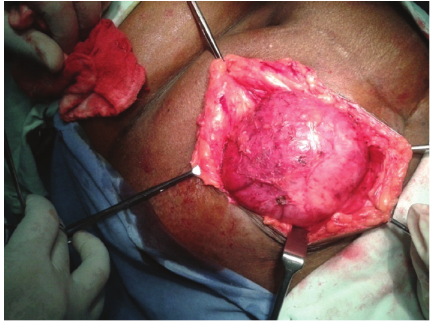
Figure 2: CECT showing large subcutaneous cyst with muscular extension and intact peritoneum.